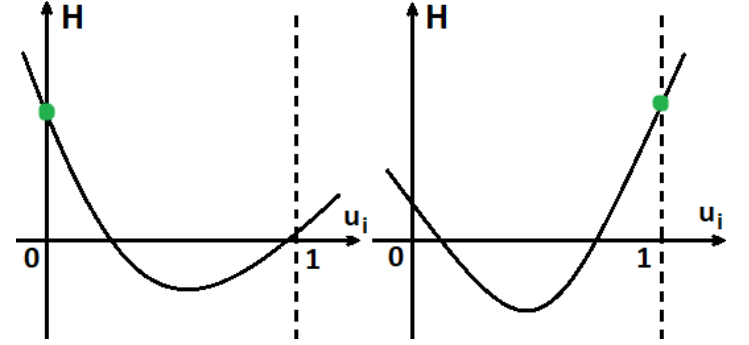
Figure 4. Hamiltonian function in a case in which functions h i ( · ) are